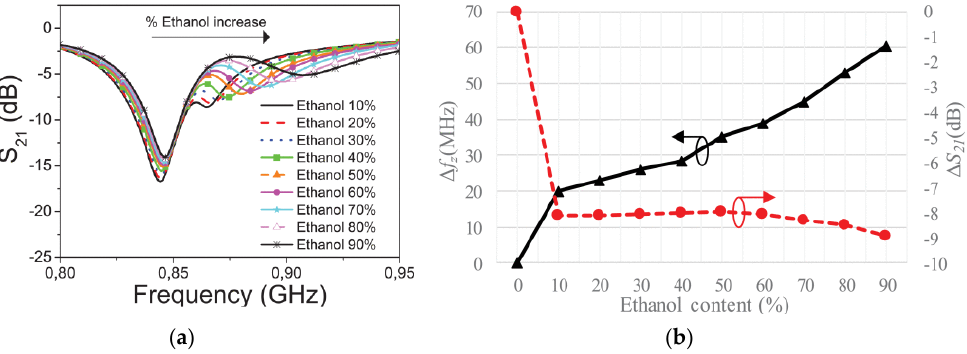
Figure 24. Measured frequency response of the sensor for various water – ethanol solutions ( a ) and representation of the resonance frequency splitting and notch magnitude difference, as a function of the ethanol concentration ( b ). From [58], reprinted with permission.